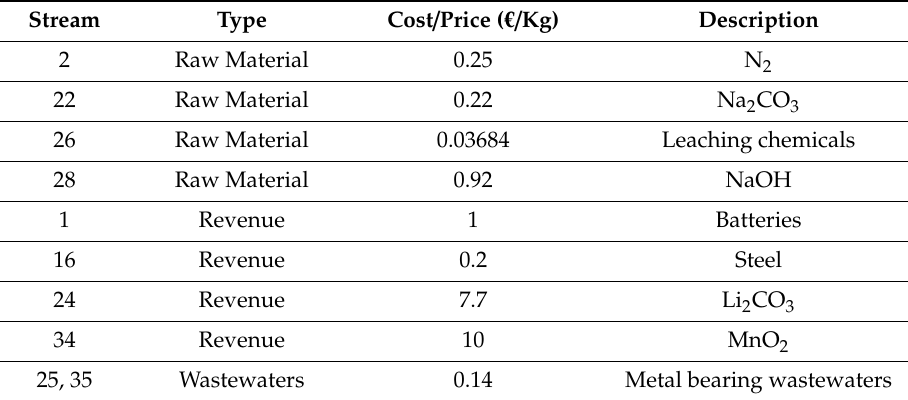
Table 2. Main economic inputs for costs and revenues used in process simulations.